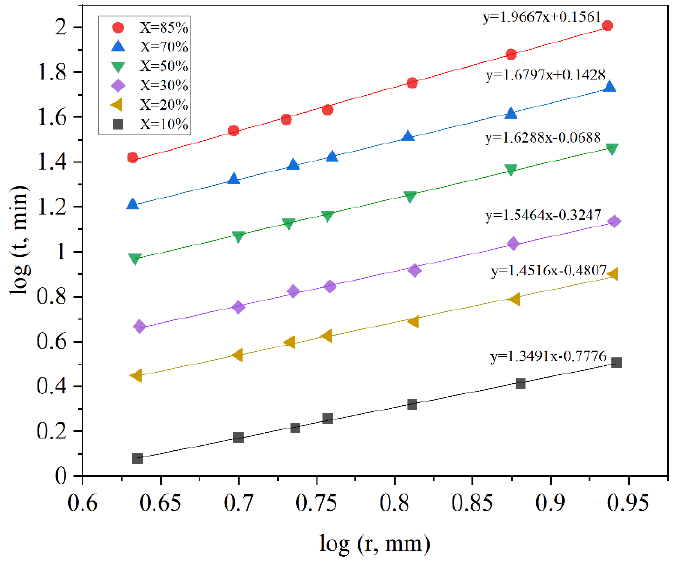
Figure 2. Plot of log (time) vs. log (particle size) for different reaction fractions [22] “modified”.